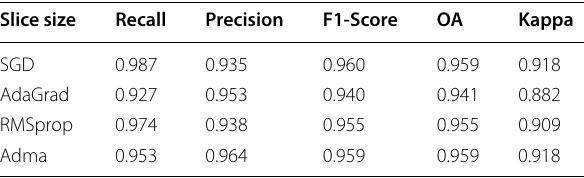
Table 3 Evaluation of the proposed model with the different slice sizes on dataset 3 Slice size Recall